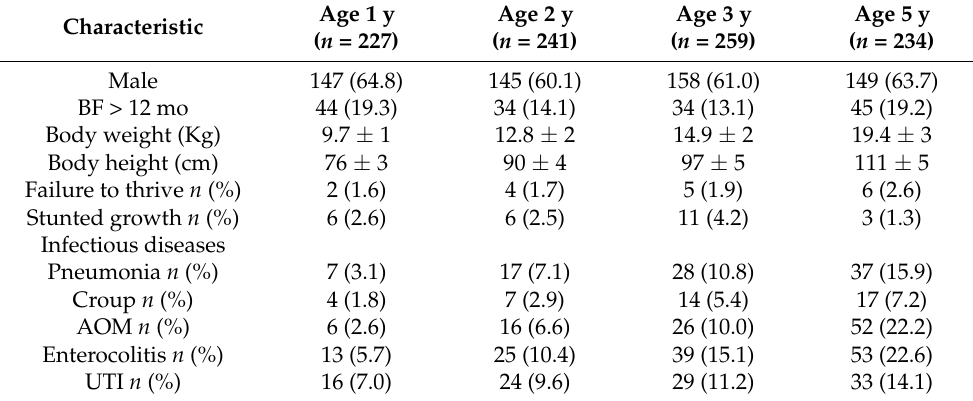
Table 1. Demographic data of the study population.